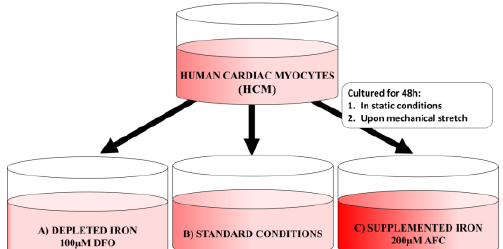
Figure 1. Schematic presentation of human cardiac myocyte (HCM) cell culture held either in static conditions or upon mechanical stretch and exposed to different iron concentrations: ( A ) decreased iron concentration (iron chelation with the use of 100 µ M DFO); ( B ) optimal iron concentration (standard iron concentration in Myocyte Growth Medium with Supplement Mix); and ( C ) increased iron concentration (iron supplementation with the use of 200 µ M AFC). DFO, deferroxamine; AFC, ammonium ferric